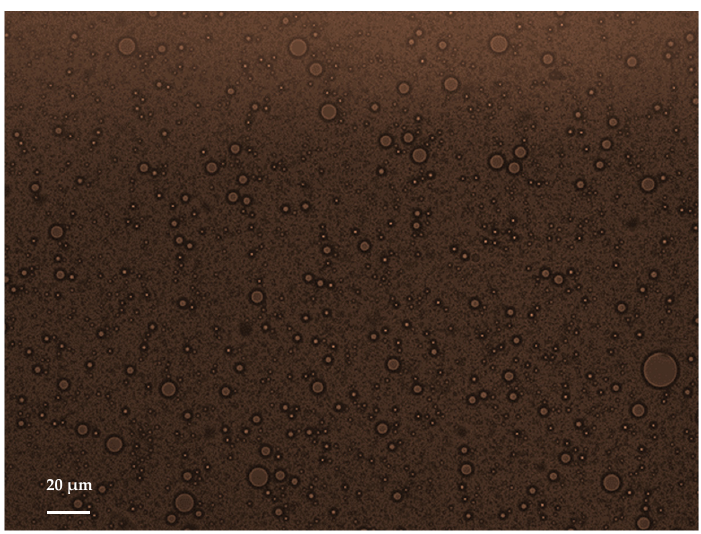
Figure 1. Representative picture of the droplets prepared with rhodamine-labelled Zonyl ® using fluorescence microscopy at room temperature.